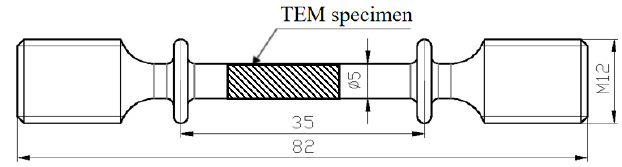
Figure 1. Geometry and size of the specimen (unit: mm).